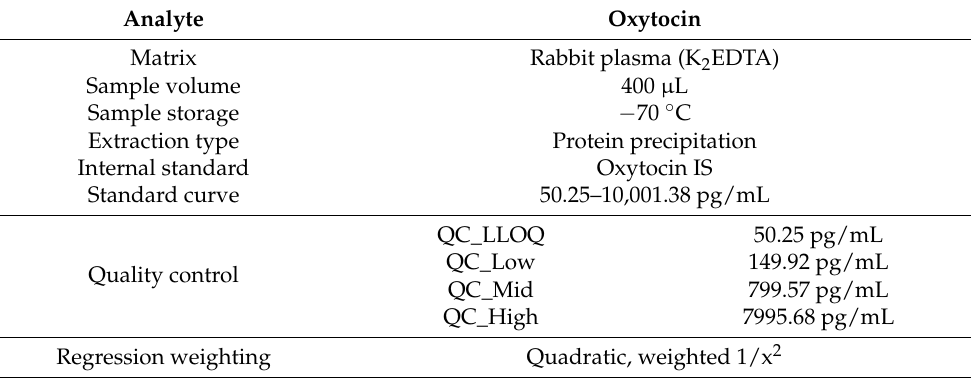
Figure 4. Individual plasma levels of oxytocin obtained via intramuscular (IM) and sublingual (SL) fast-dissolving tablet (FDT) route of administration in rabbits. Green line: Mean for SL group, Red line: Mean for IM group. Table 3. LC-MS/MS method validation summary table.